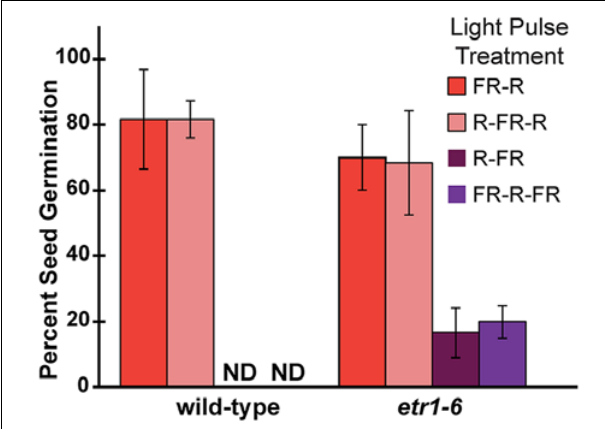
FIGURE 7 |The effect of ETR1 on germination after far-red light treatment is reversed by red light. Seeds were treated with white light for 3 h, followed by a series of 5 min pulses of red (R) and far-red (FR) light as shown.The percent of seeds that germinated was determined 7 days later.The average ± SD from at least three biological replicates is plotted. ND denotes no germination